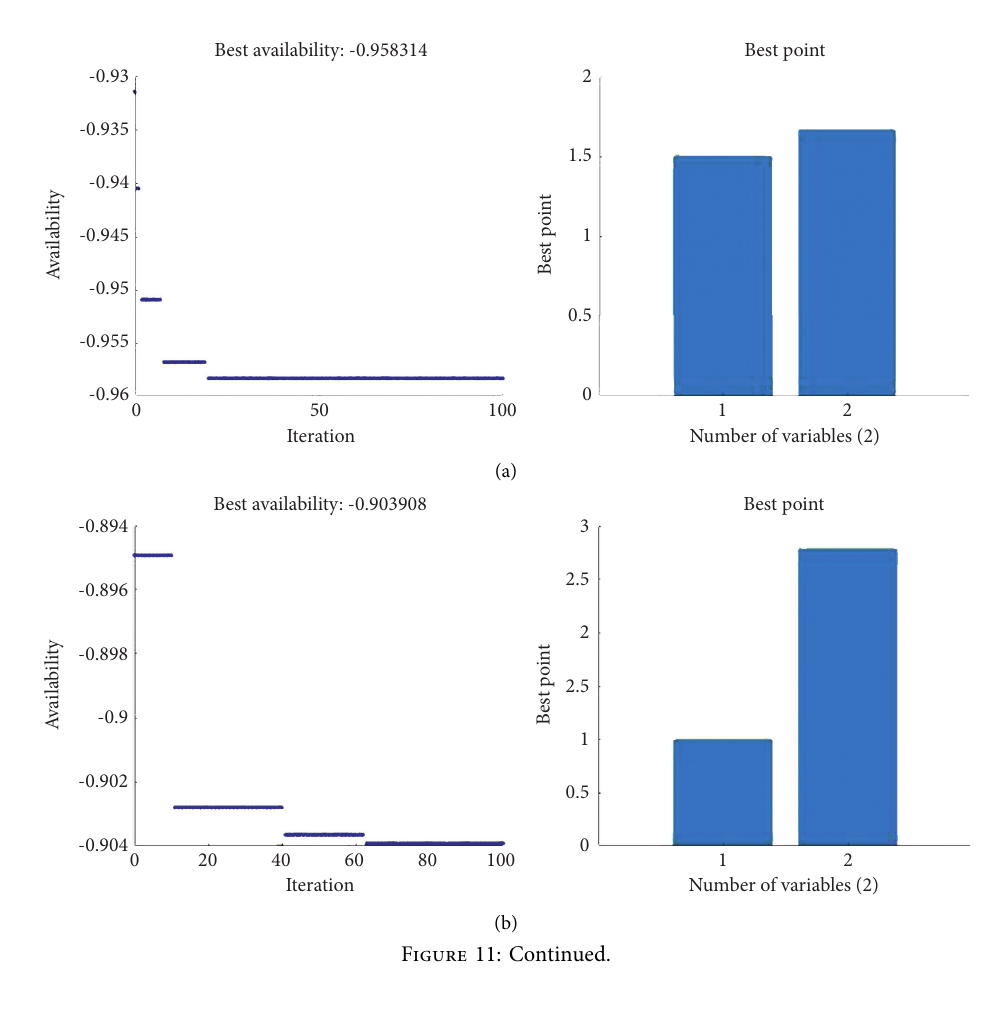
Figure 10: Variation trend of availability during the warranty period of each